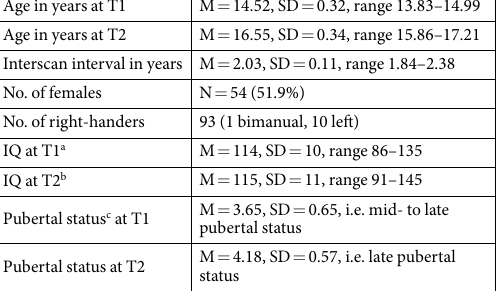
Table 2. Participant characteristics (n = 104). Note . a measured with the Wechsler Intelligence Scale For Children (WISC) that consisted of the subtests Similarities, Block Design, Vocabulary, and Matrices 61 ; b measured with the Wechsler Adult Intelligence Scale (WAIS) that consisted of the same subtests as WISC and additionally the Letter-Number Sequencing, Symbol Search, Digit Span, and Coding 62 ; c Pubertal status ranges from 1 for prepubertal to 5 for postpubertal status, measured with the Pubertal Development Scale (PDS 63 ).